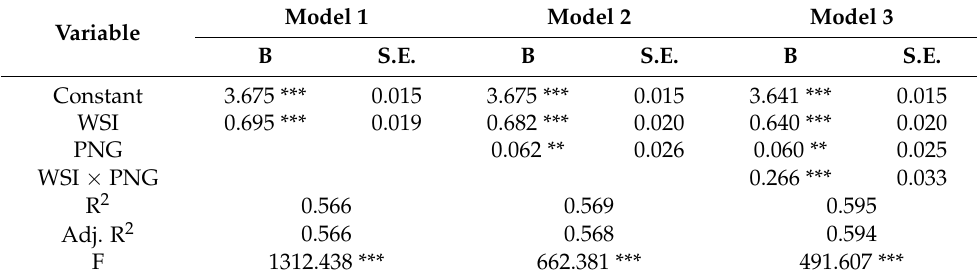
Table 8. Results of the test on the moderating effect of the publicity for China’s 14th National